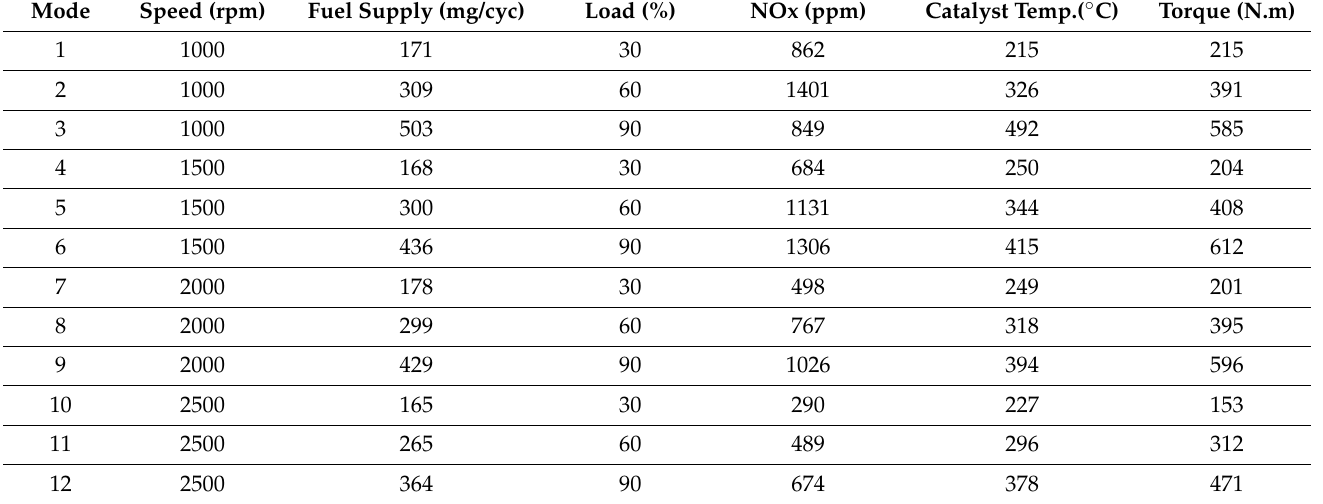
Table 7. Engine test parameters, adapted from Liu et al. [92].